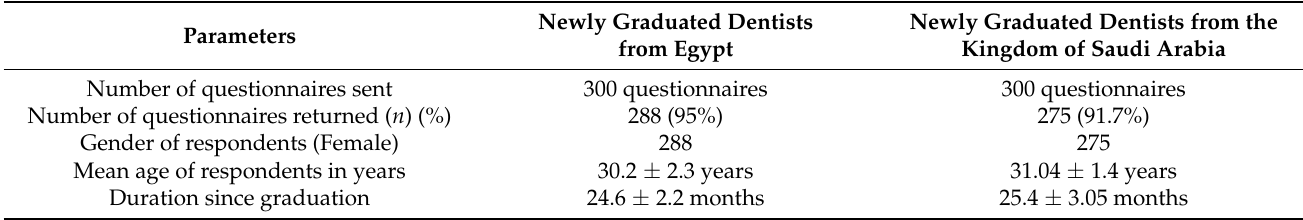
Table 2. Demographic details of the study